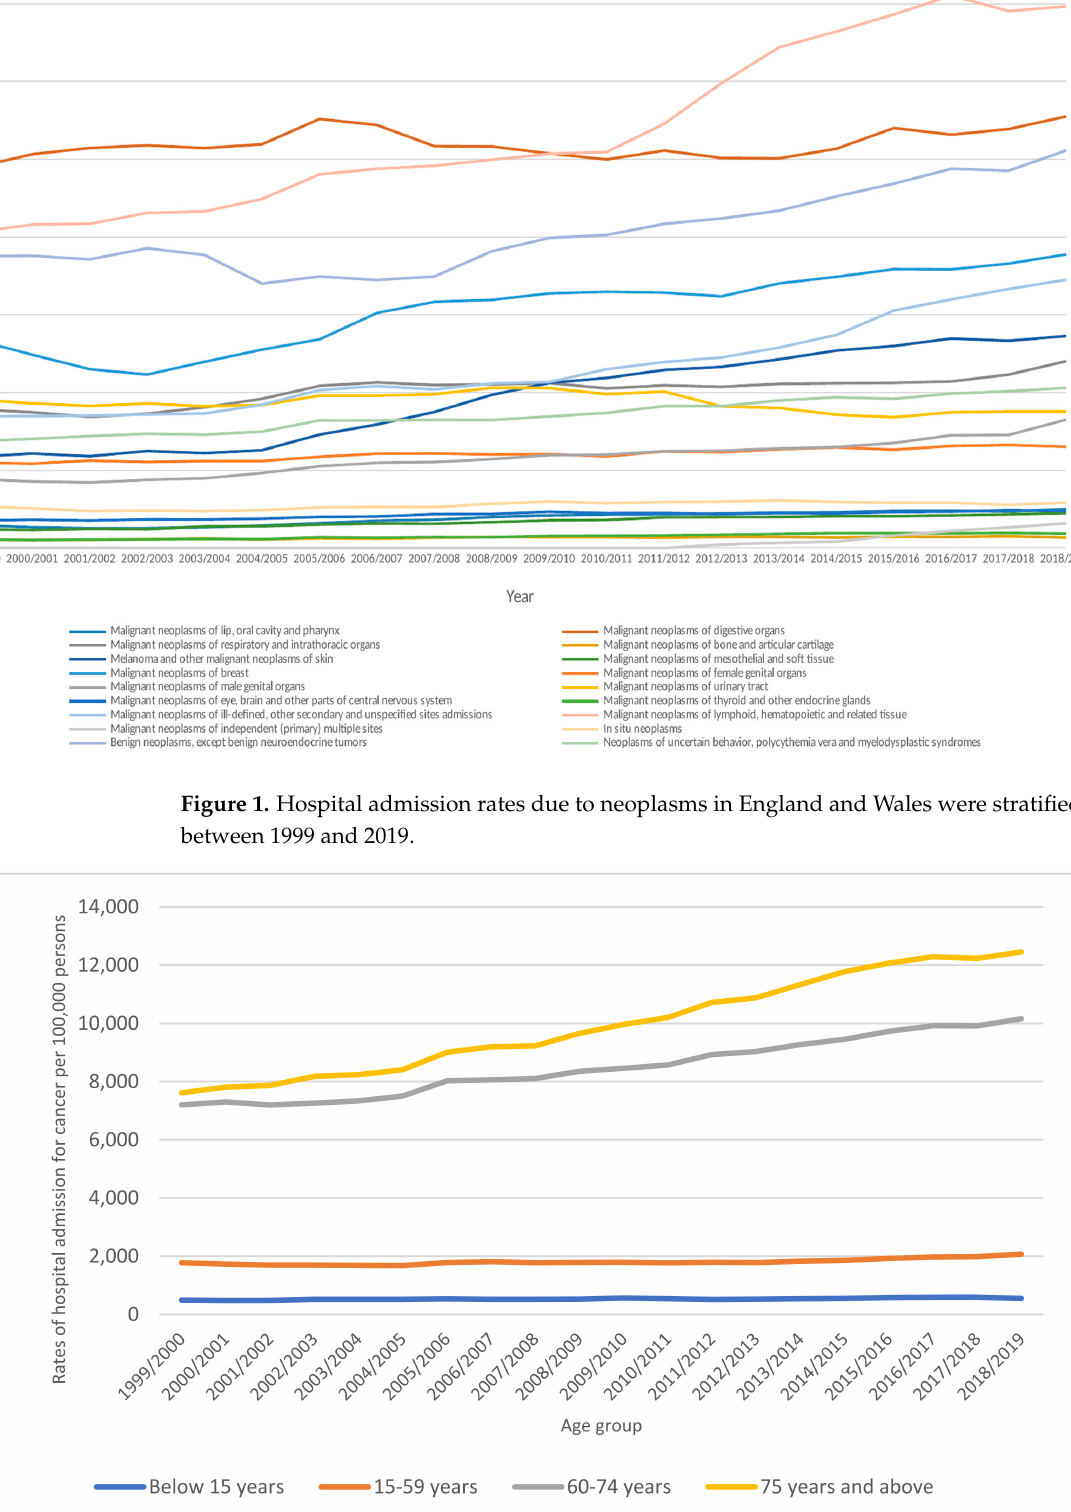
Figure 2. Rates of hospital admission for all neoplasms in England and Wales stratified by age group between 1999 and